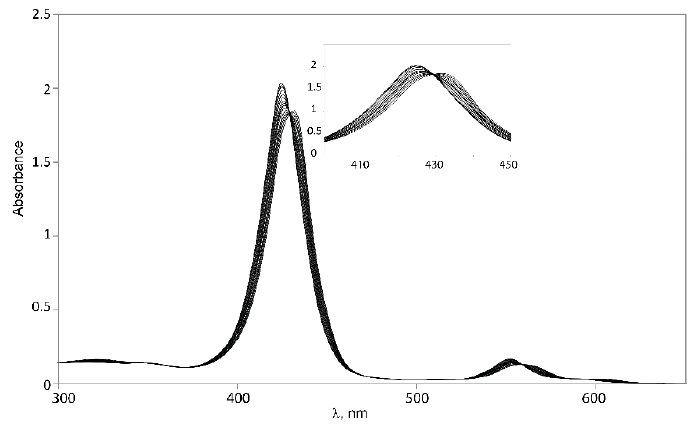
Figure 7. Isosbestic points for binding of 1,6-diaminohexane 21 to Z- 2 .